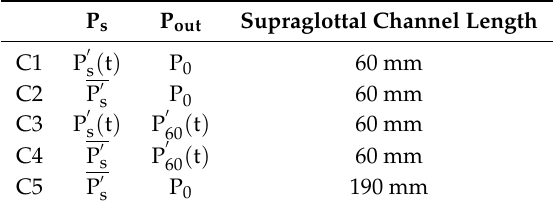
Figure 3. Experimental ( a ) subglottal pressure waveform (P (cid:48) s ( t ) ) and ( b ) pressure waveform at 60 mm ( t ) ). The red lines are the corresponding mean pressure values. downstream of the glottis exit (P (cid:48) 60 Table 1. Simulation cases with boundary conditions for comparison with the experimental results. P (cid:48) ( t ) , P s , P out and P 60 are the time-varying experimental pressure, subglottal pressure, outlet pressure and pressure at 60 mm downstream of the glottis exit,